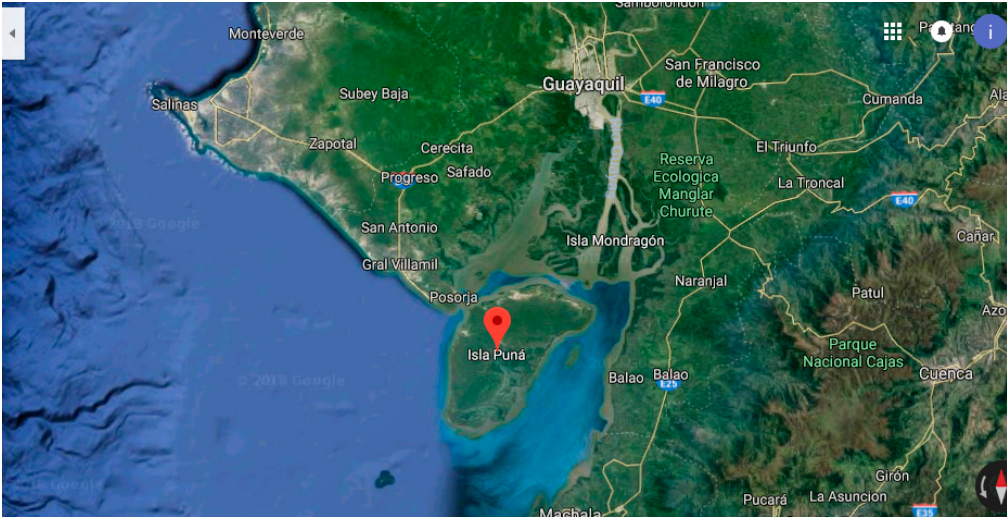
Figure 1. Satellite view of Puná Island. Source: [3]. Table 1. Geographical coordinates of the perimeter of Puná Island. Source: [1]. Geographical Coordinates Point